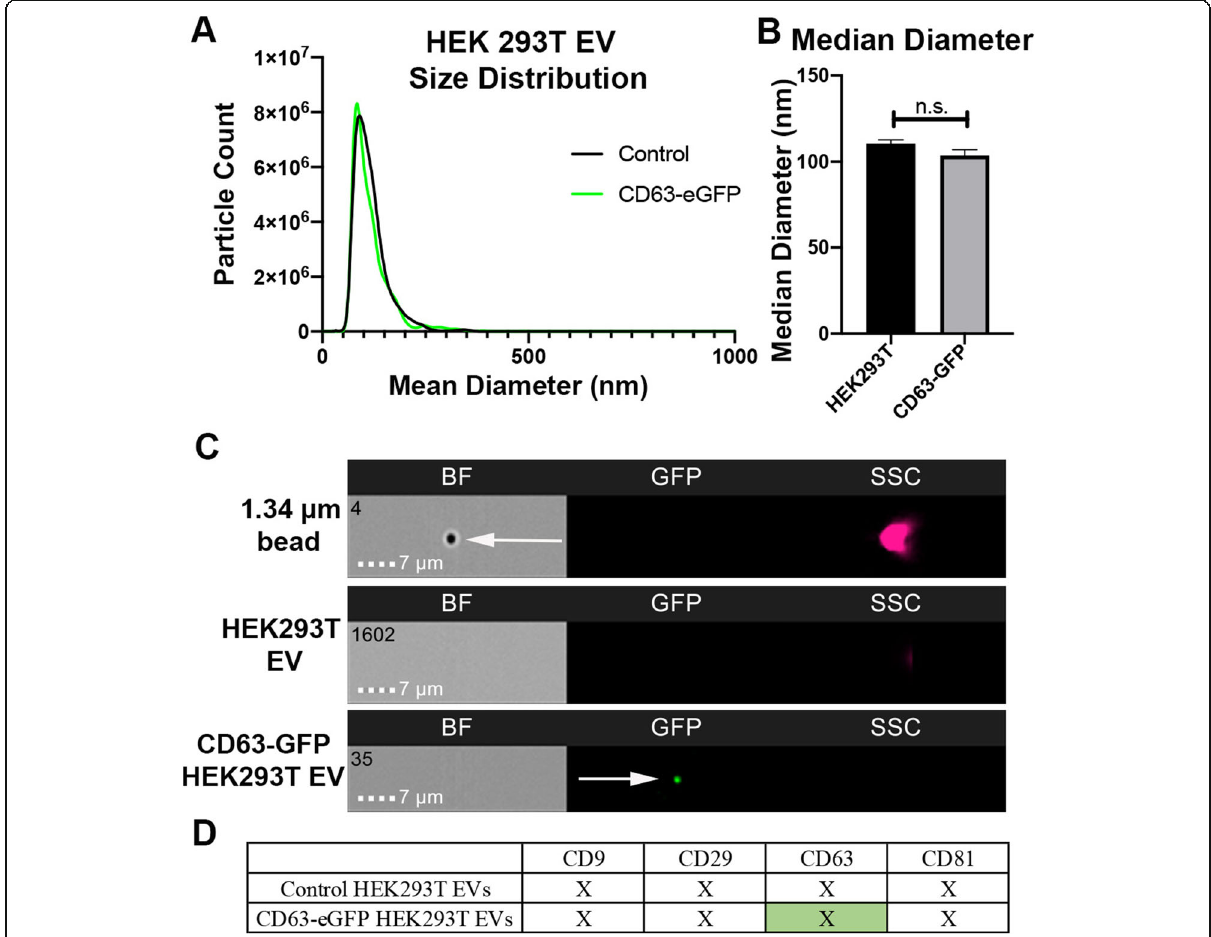
Fig. 1 Characterization of HEK293T EVs tagged with CD63-eGFP. EVs were isolated from HEK293T (control) and HEK293T expressing CD63-eGFP cell culture media. a Representative EV size distribution recorded via nanotracking software. b Quantification of mean diameter distribution of transfected vs. non-transfected HEK293T EVs. c IFC images of negative control beads, HEK293T control EVs, and CD63-eGFP – tagged EVs. BF signifies bright field, GFP signifies green fluorescent protein (488 nm excitation laser), and SSC signifies side scatter. Positive eGFP in GFP channel signifies fluorescent HEK293T EVs. d Flow cytometry-based MACSPlex surface marker expression of non-transfected HEK293T EVs and HEK293T CD63-eGFP EVs. Both EV sources are positive for CD29, CD9, CD63, and CD81, as measured in relative fluorescence (denoted by X for positive). Bars represent mean ± SEM; N = 3; unpaired T test. n.s. signifies p >